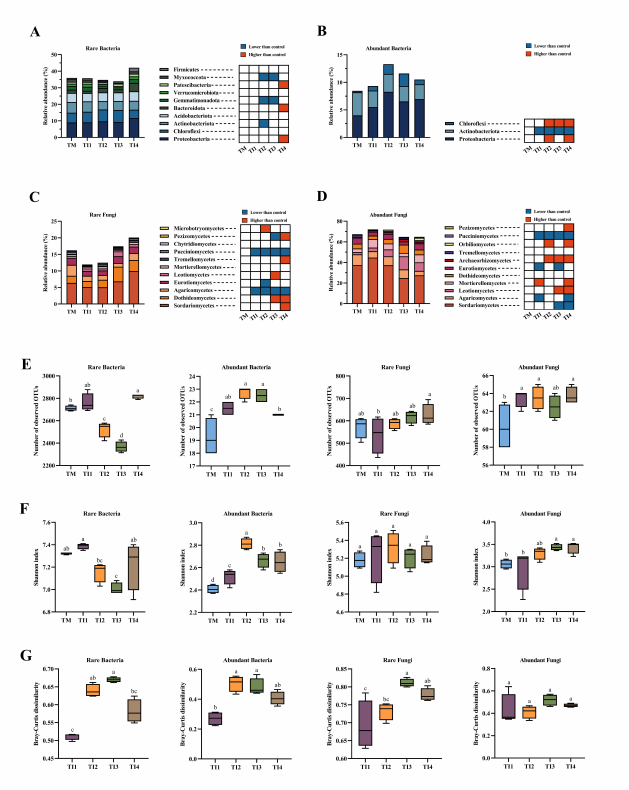
Figure 3. Composition and diversity of rare/abundant microbial taxa in different treatments. Relative abundance at phylum level (>0.5%) in ( A ) rare; and ( B ) abundant bacterial communities. Relative abundance at class level (>0.1%) in ( C ) rare; and ( D ) abundant fungal communities. Rare and abun- dant bacterial and fungal communities α -diversity: ( E ) number of observed OTUs; and ( F ) Shannon index in different treatments; and ( G ) pairwise Bray–Curtis dissimilarities between communities in each intercropping practice and monoculture were calculated. Bacterial phylum or fungal class with significantly higher or lower abundance in intercropping practices than monoculture are colored red or blue, respectively ( p < 0.05). Boxplot shows median, first and third quartiles, and whiskers are maximum and minimum values. Different letters represent significant differences between treatments ( p < 0.05). Treatments include tea-plant monoculture (TM), tea intercropping with soybean (TI1), tea intercropping with soybean—milk vetch (TI2), tea intercropping with soybean—red clover (TI3), and tea intercropping with soybean—smooth vetch